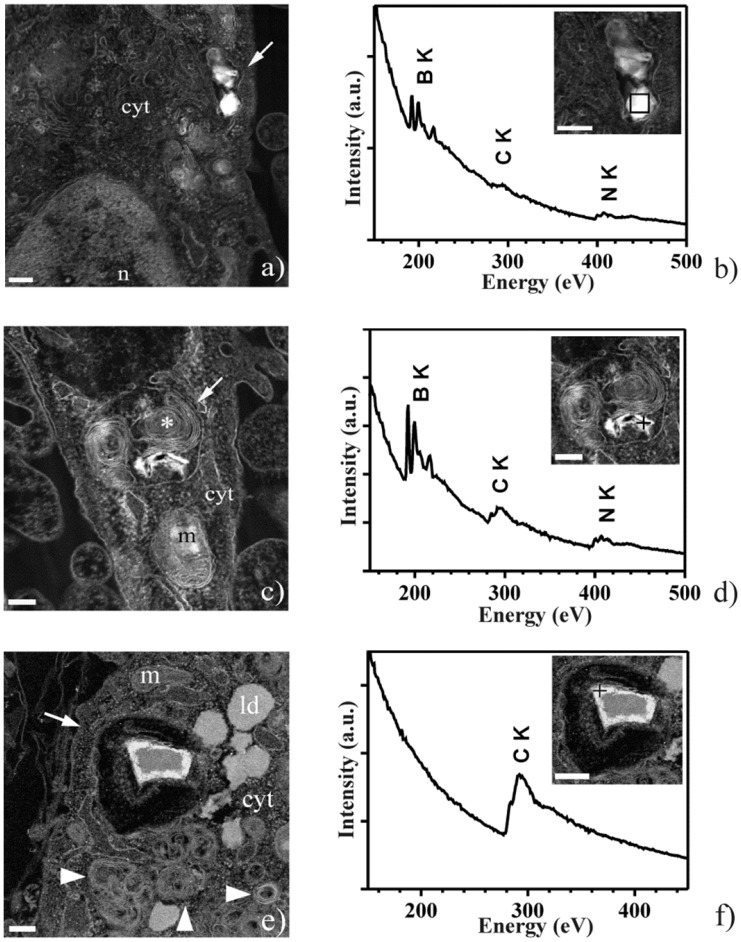
Proof of presence and intracellular localization of GC-conjugated BNNTs inside C2C12 myoblasts co-cultured with nHDFs via scanning TEM-high angle annular dark field (STEM-HAADF) coupled with energy electron loss spectroscopy (EELS).(a) STEM-HAADF image of part of a myoblast. The arrow points to an early endosome containing the GC-conjugated BNNTs. (b) EEL spectrum collected from the area boxed in the inset, showing the core-loss K edges of B and N, confirming that the selected nano-object is indeed a bundle of BNNTs. (c) STEM-HAADF image of part of another myoblast. The arrow points to a late endosome containing the GC-conjugated BNNTs. Note the multilamellar stack (asterisk) that is inside the late endosome. (d) EEL spectrum collected from the area pointed in the inset (+), confirming the presence of BNNTs. (e) STEM-HAADF image of a portion of a fibroblast showing several multilamellar bodies (arrowheads) close to an endosome (arrow). (f) EEL spectrum collected from the feature pointed in the inset (+), showing that the selected object does not contain BNNTs. Abbreviations: cyt, cytoplasm; ld, lipid droplet; m, mitochondrion; n, nucleus. Scale bars are 200 nm in panels (a-d), 300 nm in panel (e) and 400 nm in (f).